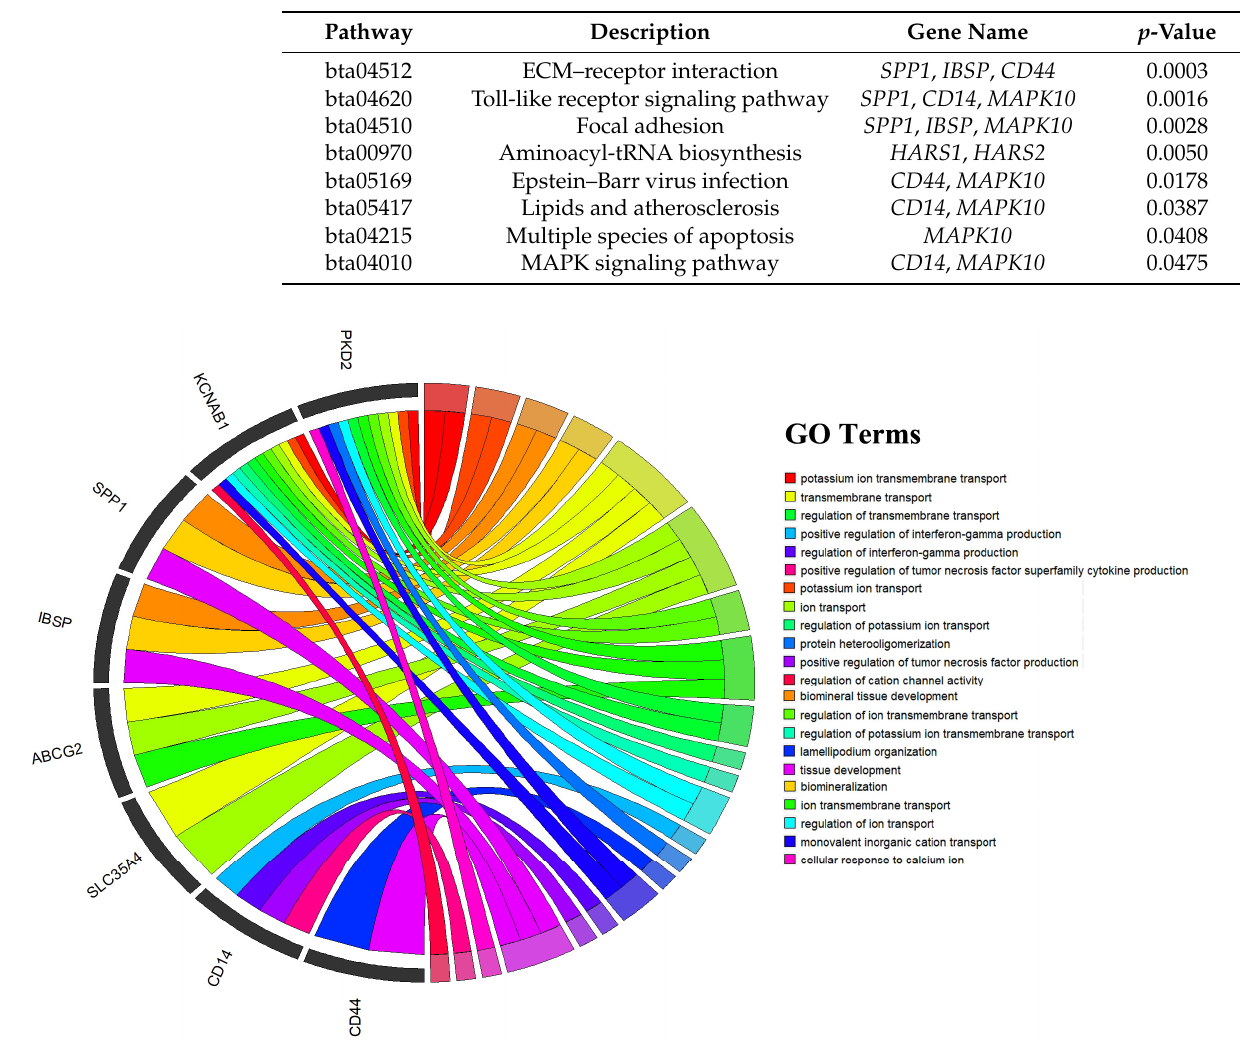
Table 4. KEGG pathway information of the nearest genes and the genes within 200 kb of the significant SNPs.